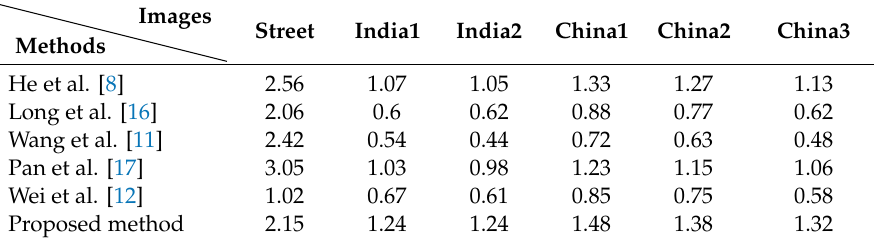
Table 4. Comparison results of r using various